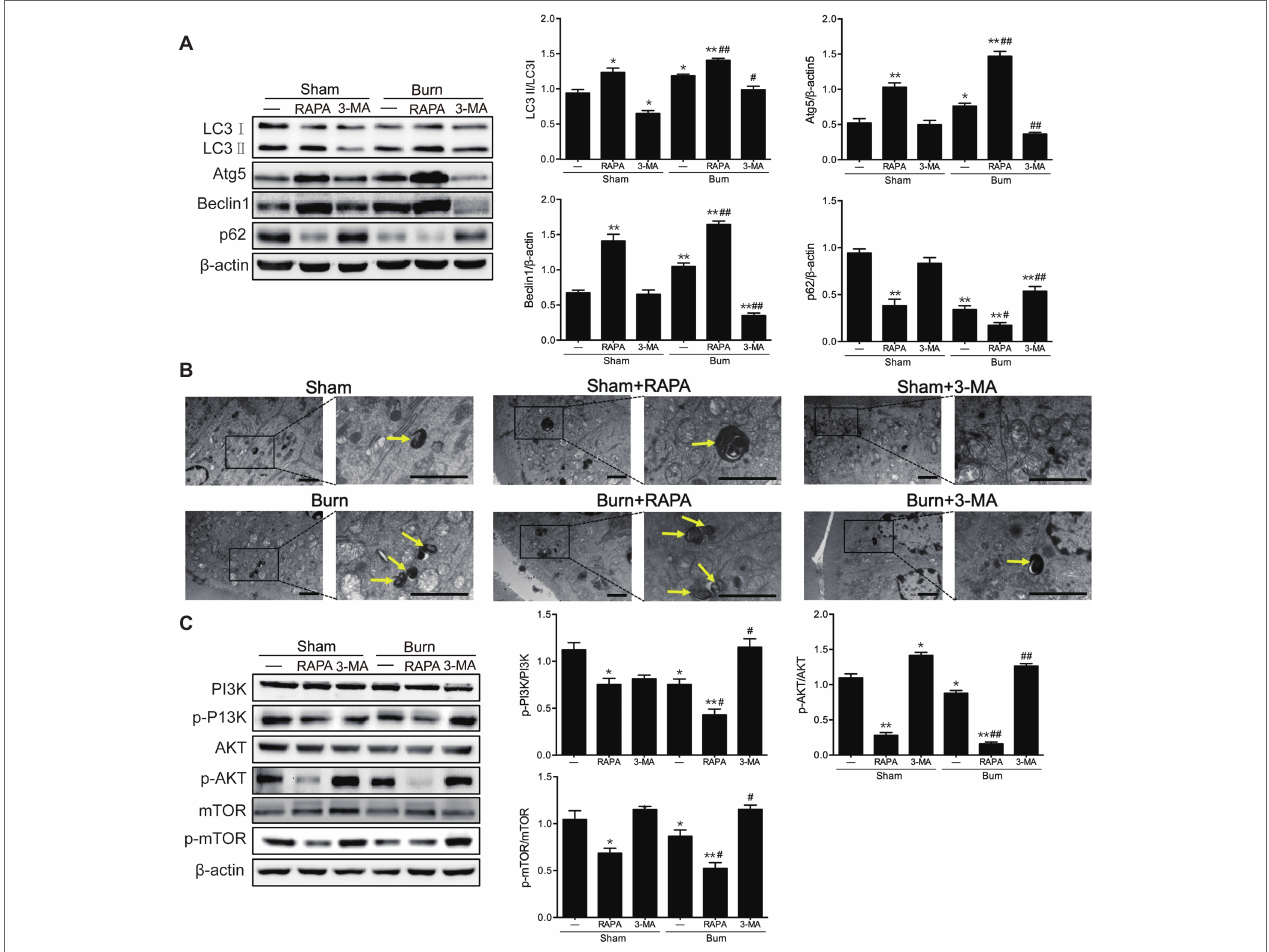
FIGURE 3 | Severe burn-induced autophagy activation is exacerbated by autophagy inducer and suppressed by autophagy inhibitor. Mice were treated with or without rapamycin (4 mg/kg) and 3-methyladenine (15 mg/kg), respectively, for 1 h and then given the sham or 30% TBSA burn. (A) The ileal mucosa lysates were taken at 6 h after sham burn or burn injury and then analyzed for the expression of autophagy markers by immunoblot, with β -actin as loading control. Data represent mean ± SEM. * p < 0.05, ** p < 0.01, compared with sham-burn group ( n = 5). # p < 0.05, ## p < 0.01, compared with burn group ( n = 5). (B) Representative autophagosome (yellow arrow) images of intestinal epithelial cells from sham-burned or burned mice under transmission electron microscopy (TEM). Scale bar = 2.0 μm. n = 5. (C) The ileal mucosa lysates were analyzed for the expression of PI3K/AKT/mTOR pathway molecules by immunoblot. Data represent mean ± SEM. * p < 0.05, ** p < 0.01, compared with sham-burn group ( n = 5). # p < 0.05, ## p < 0.01, compared with burn group ( n =